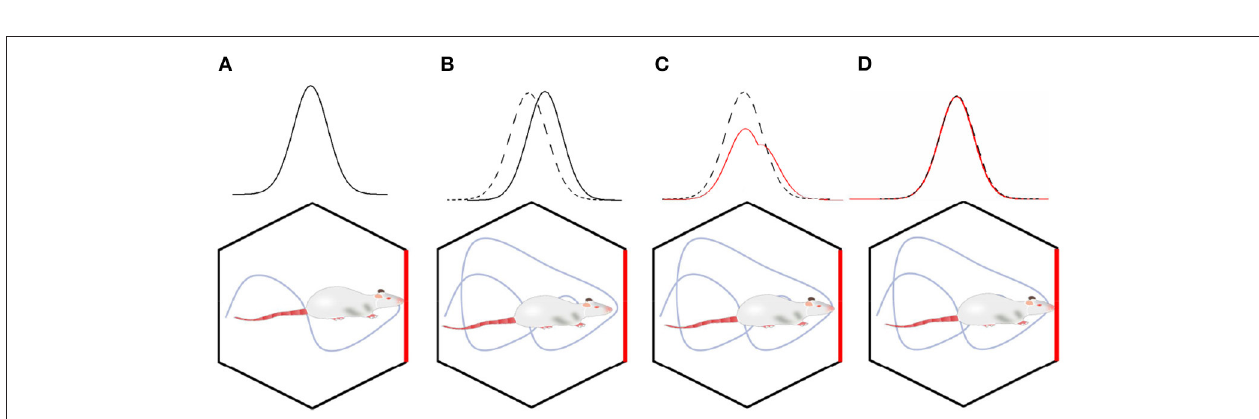
FIGURE 6 | The mechanism of boundary cells correcting spatial cognitive errors. (A) In the initial exploration phase, the grid cells’ activation pattern and boundary cells’ activation pattern are associated with memory. (B) When the boundary cells are activated again, the grid firing pattern has deviated. (C) Boundary cells correct grid cell pattern by weight connection. (D) The error correction has been completed, the memory of grid cells activation pattern and boundary cells activation pattern are